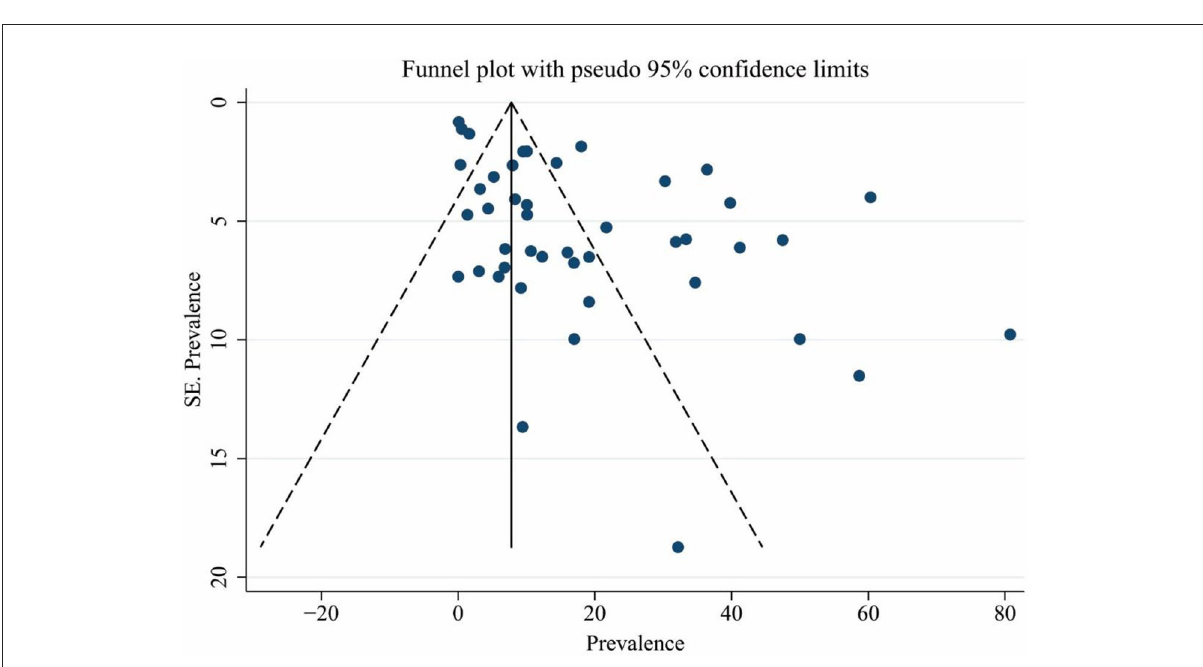
FIGURE6 Funnel plot for assessing publication bias. The vertical and horizontal axes show the prevalence of brucellosis and the standard error of prevalence.